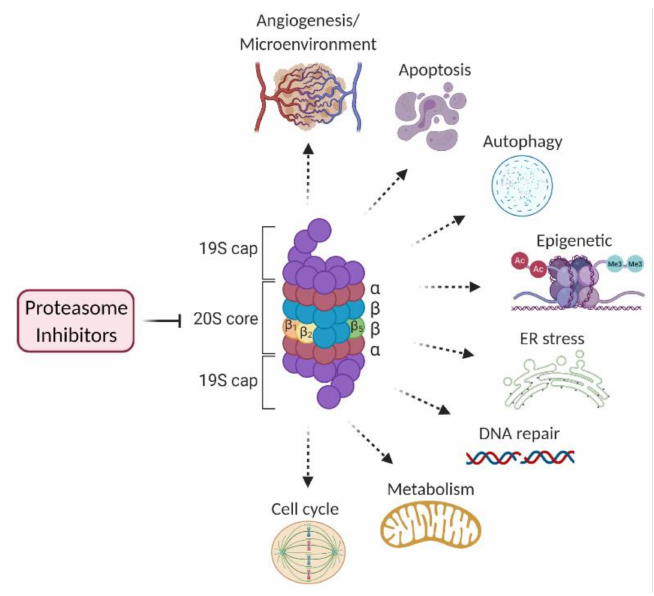
Figure 1. Cellular processes affected by proteasome inhibition. Druggable targets within these pathways are a reservoir of synthetic lethal partners to proteasome inhibitors